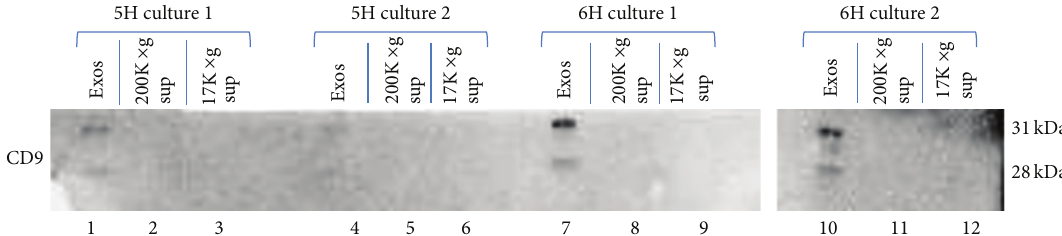
Figure4:SDS-PAGEandWesternblottingofsamplesfromdifferentstagesofexosomeisolationbyultracentrifugation:17,000 × gsupernatant, 200,000 × g supernatant, and 200,000 × g (exosome pellet) from samples of 5H (lanes 1–6) and 6H media (lanes 7–12) collected from confluent cultures of FRTL-5 cells incubated for 48 hours. Western blots were treated with a monoclonal anti-CD9 antibody and developed using SuperSignal West Femto. All exosome samples contained 15 𝜇 L of resuspended pellet from the 200,000 × g ultracentrifugation. 5H samples exhibited small, barely detectable bands for CD9 though some CD9 was present, while 6H samples exhibited much stronger CD9 signals indicating larger amounts of exosomes. “Exos” = exosomes (i.e., 200,000 × g